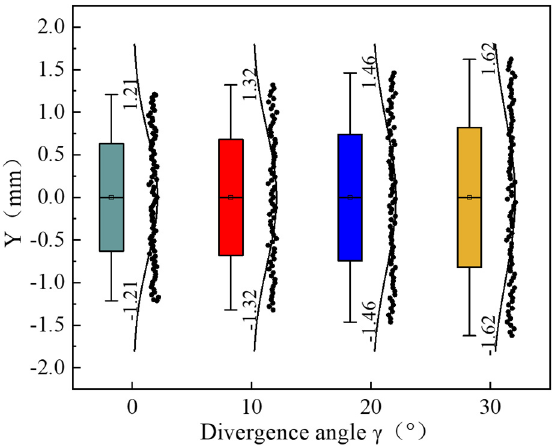
Figure 7. Effect of divergence angle on the effective Y-axis extension distance of the water jet at X = 100 mm. X = 100